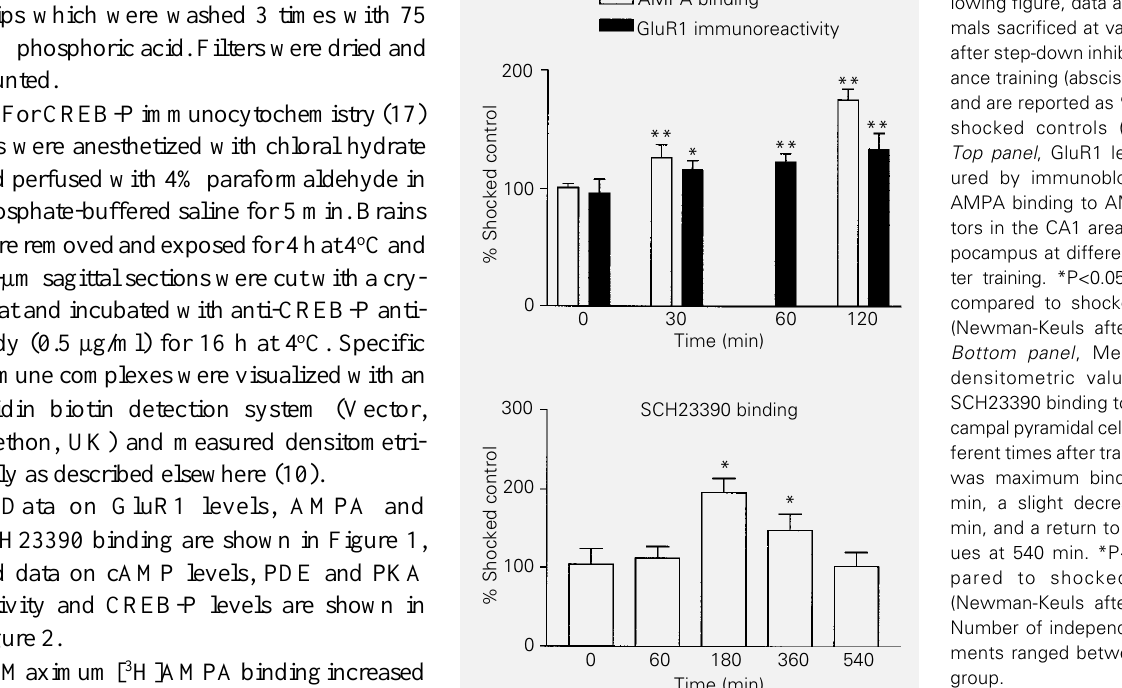
Figure 1 - In this and in the fol- lowing figure, data are from ani- mals sacrificed at various times after step-down inhibitory avoid- ance training (abscissae, in min) and are reported as % values of shocked controls (ordinates). Top panel , GluR1 levels meas- ured by immunoblot and [ 3 H] AMPA binding to AMPA recep- tors in the CA1 area of the hip- pocampus at different times af- ter training. *P<0.05, **P<0.01 compared to shocked controls (Newman-Keuls after ANOVA). Bottom panel , Mean – SEM densitometric values of [ 3 H] SCH23390 binding to the hippo- campal pyramidal cell layer at dif- ferent times after training. There was maximum binding at 180 min, a slight decrease at 360 min, and a return to control val- ues at 540 min. *P<0.01 com- pared to shocked controls (Newman-Keuls after ANOVA). Number of independent experi- ments ranged between 5-8 per